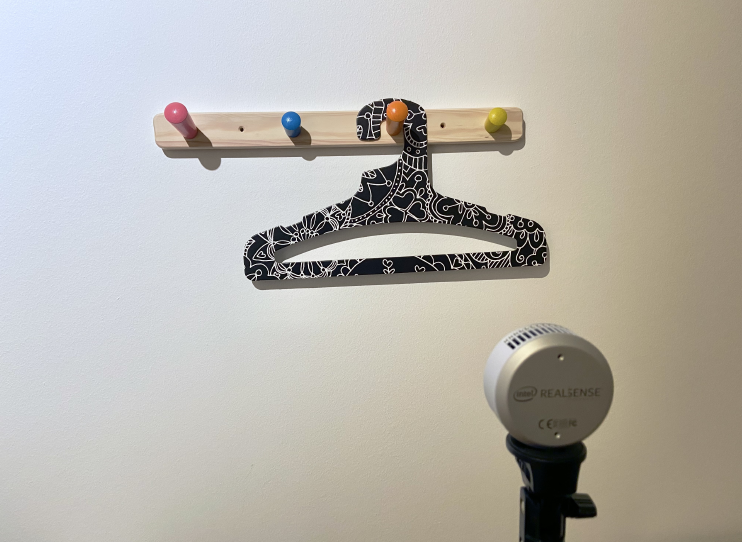
Figure 4. The setup. A LiDAR-based depth camera on a tripod standing in front of the experi- ment scene.